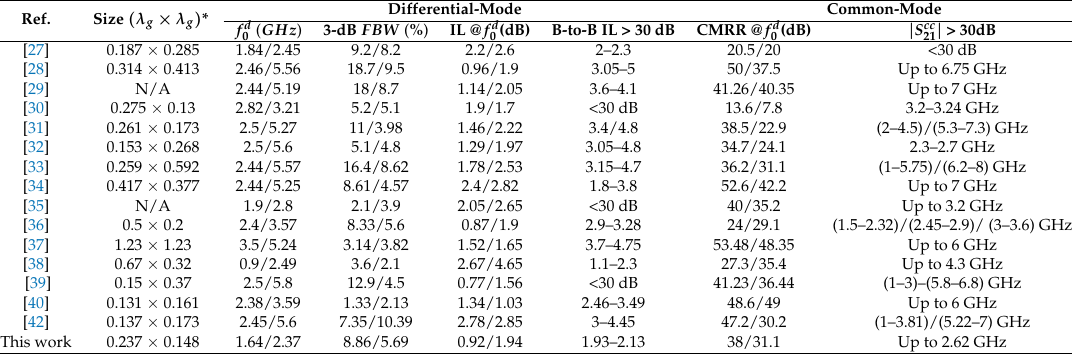
Table 1. Comparison with reported balanced dual-band bandpass filters.